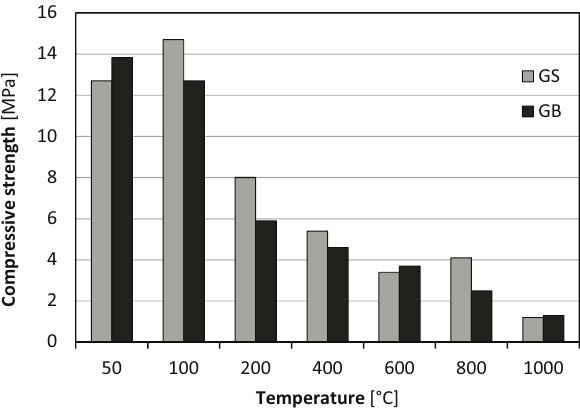
Figure 14: Compressive strength after exposition to high temperatures.